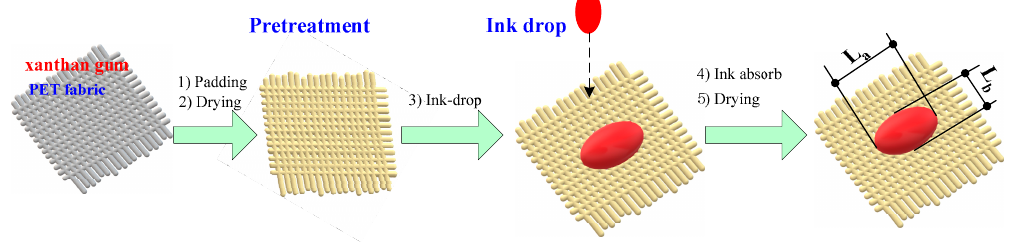
Figure 2. Flowchart of ink drop experiment on the pretreated PET fabric.